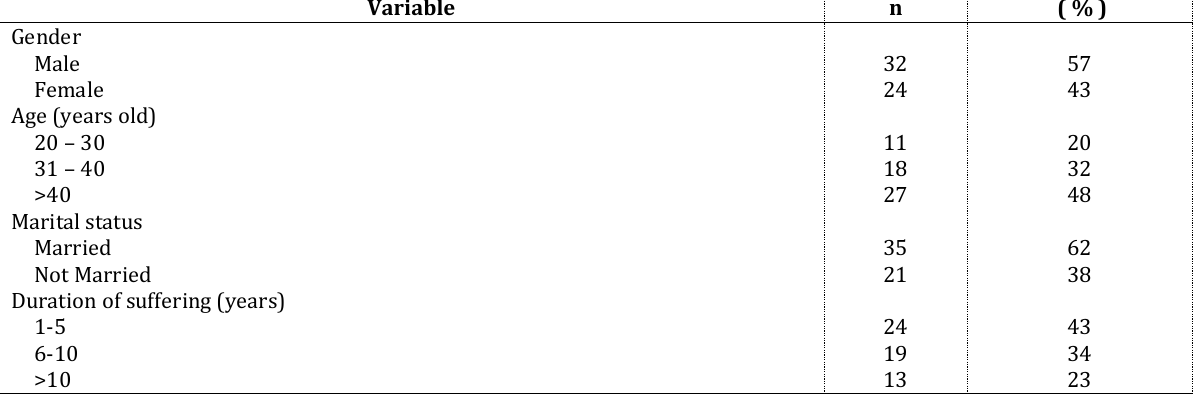
Table.1 Respondents ’ Characteristics of Leprosy Patients in Probolinggo District.